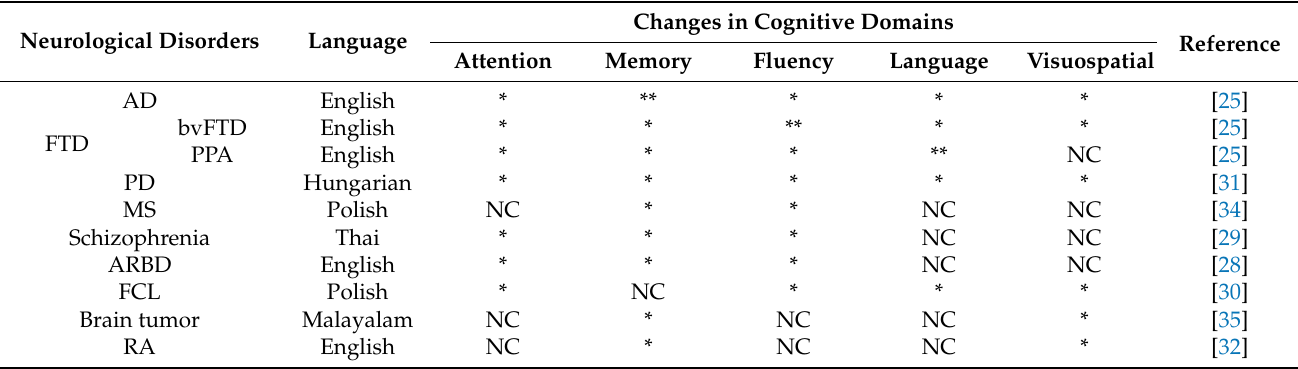
Table 2. Cognitive domain decline tested by ACE-III for neurological